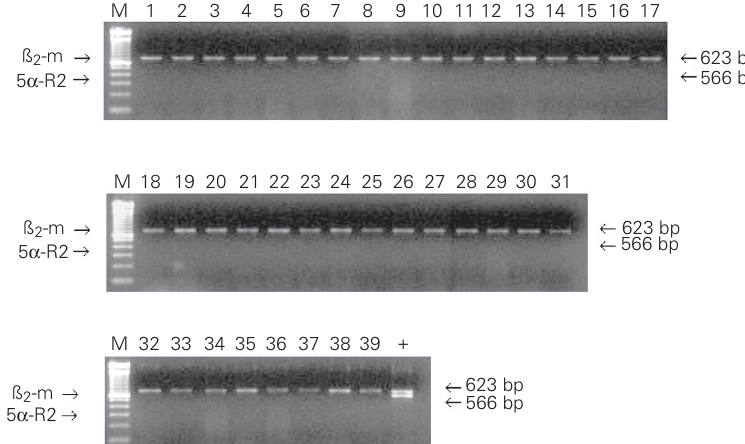
1. Representative agarose gel stained with ethidium bromide showing no expres- sion of SDR5A2 mRNA by RT-PCR in hair cells plucked from the scalp of men (1 to 9), normal women (10 to 17) and hirsute patients: PCOS group (18 to 31) and IH group (32 to 39). The 566-bp fragment corresponds to SDR5A2 (5 α -R2) and the 623-bp fragment corresponds to ß 2 -microglobulin (ß 2 -m). SDR5A2 amplification was visualized only in dissociated prostatic cells used as positive control